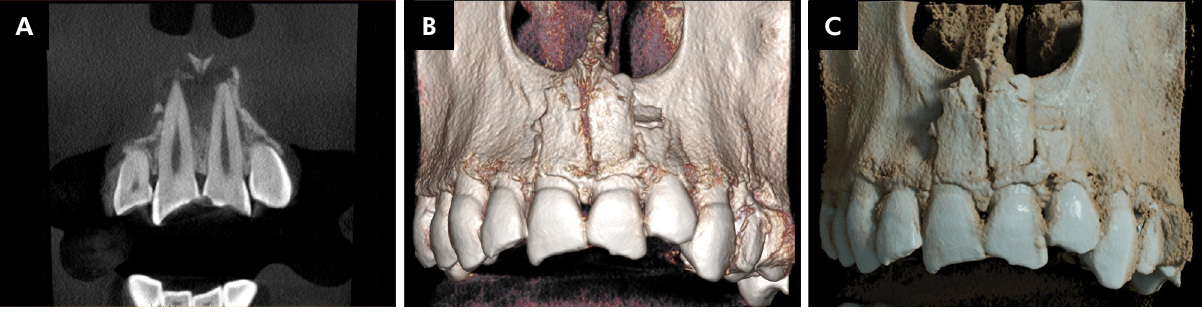
Figure 2. Case 1 (A-C). A 36-year-old woman was referred to a private oral and maxillofacial radiology clinic (CROIF, Cuiabá, Brazil) for imaging studies to assess trauma that resulted in fracture of the crown of maxillary incisors. Clinical examination revealed upper lip edema. Her medical history was negative for any comorbidities. A CBCT scan showed fracture of the crowns of maxillary incisors. In addition to that, her diagnosis included lateral and partially intrusive luxation of central incisors and fracture of the alveolar ridge. The e-Vol DX software and its advanced photorealistic 3D rendering tool (C) provided elements for a better analysis of fragment shapes and the position of the alveolar fracture and supported the decision about repositioning of the tooth and the fragments.